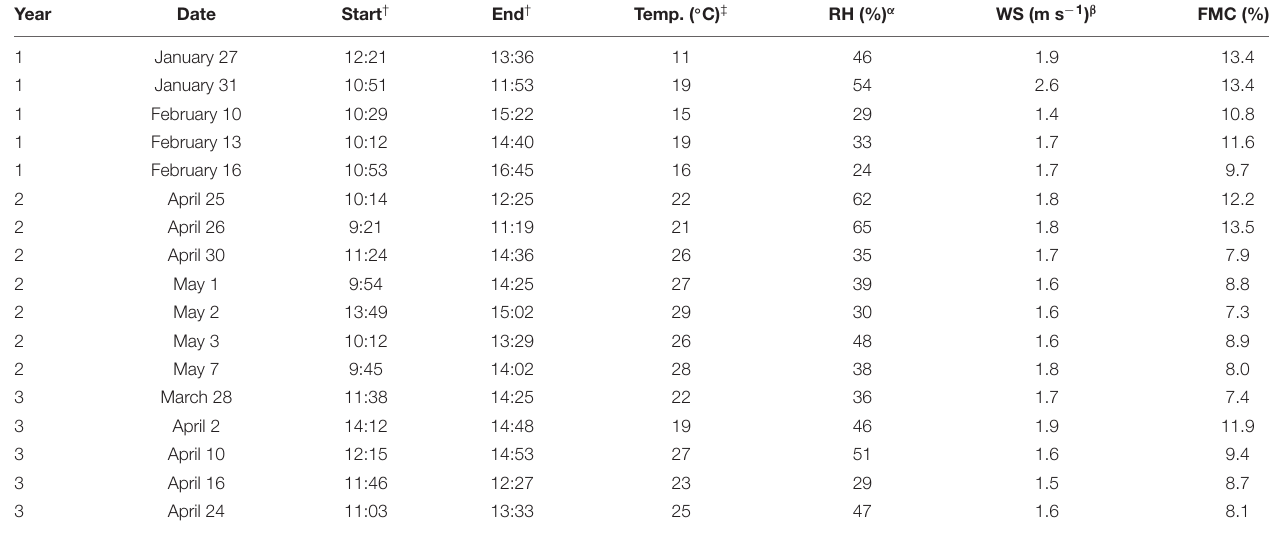
TABLE 2 | Average fire weather during experimental prescribed fires (2017–2019) in longleaf pine woodlands in southwest Georgia, United